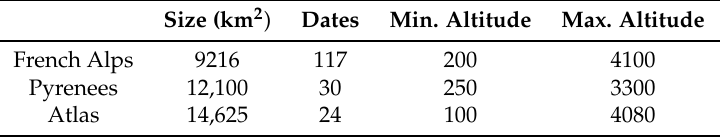
Figure 1. The three areas of interest in the French Alps ( a ), the Pyrenees ( b ), and the Moroccan Atlas ( c ). The land cover types for the Alps and Pyrenees shown to the right of the figure are from the Corine Land Cover library [20] at a spatial resolution of 30 m. Land cover for Morocco was obtained from classification of MODIS using imagery at a spatial resolution of 500 m from [21]. Table 1. Main characteristics of the three areas